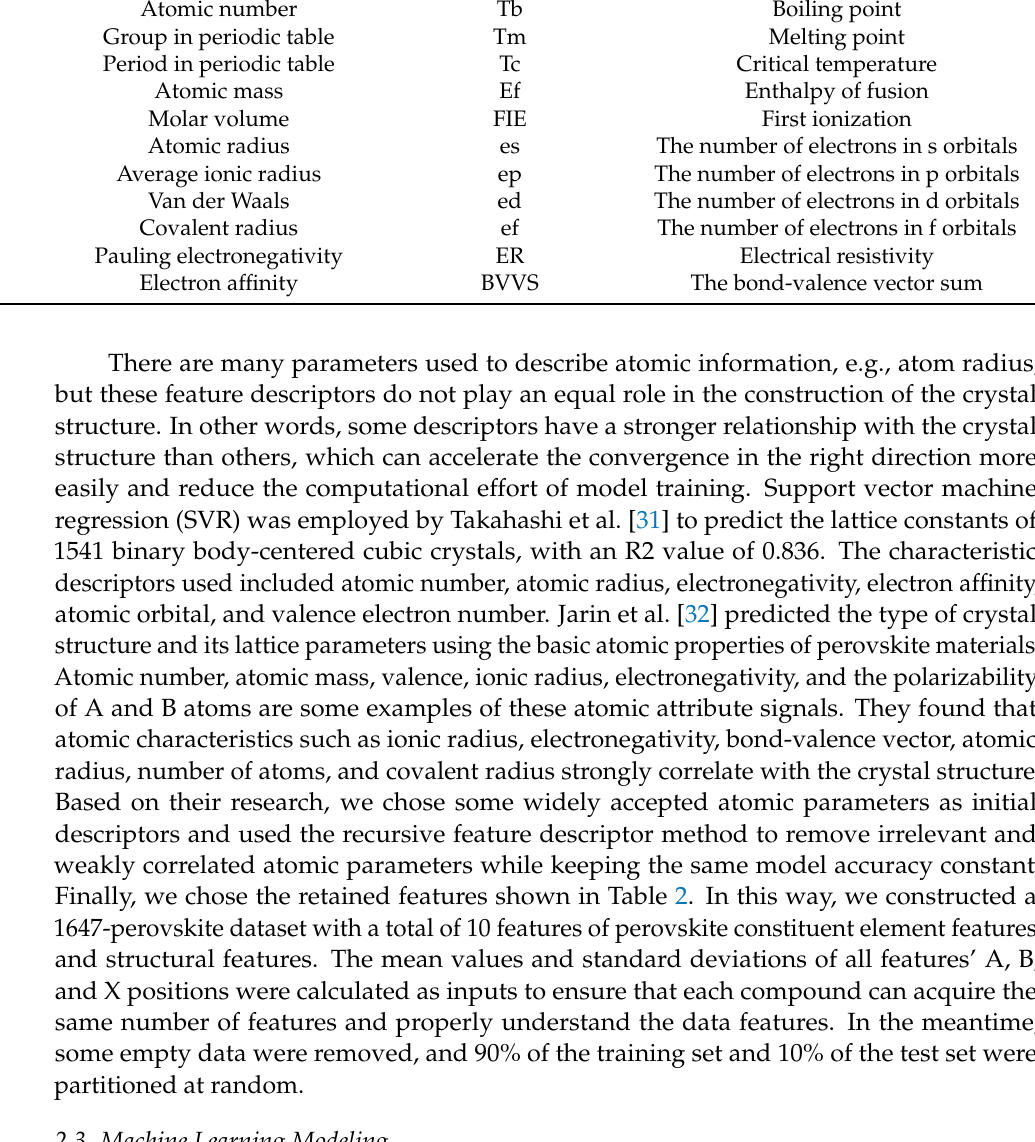
Table 1. Perovskite original feature descriptor set and its physical meaning.